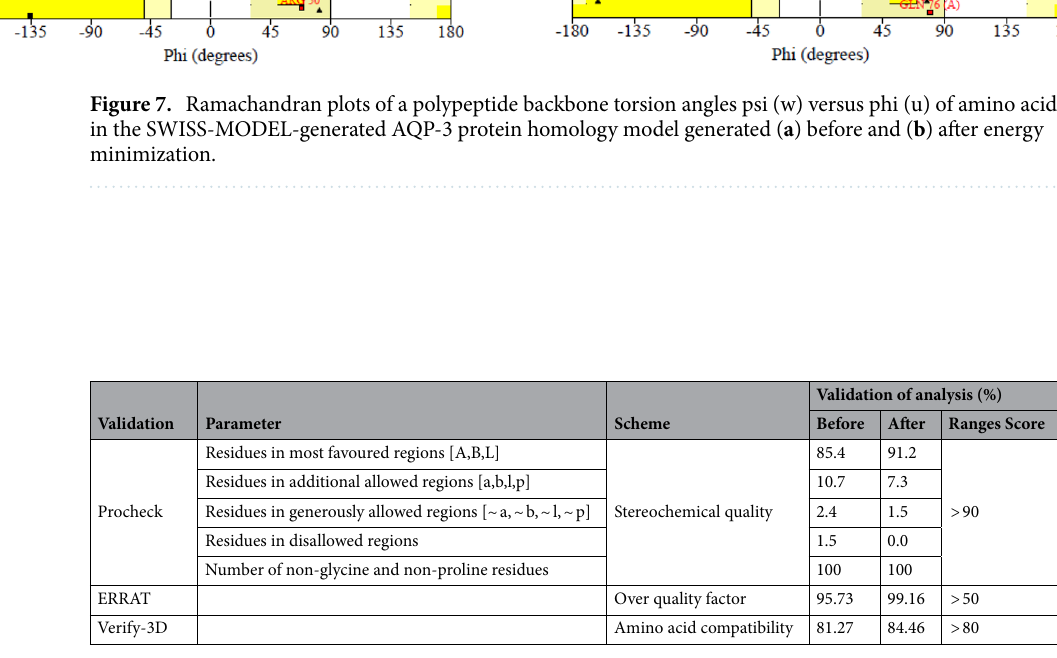
Table 3. Results of structural validation of AQP-3 protein model with the SAVEs Server (before and after energy